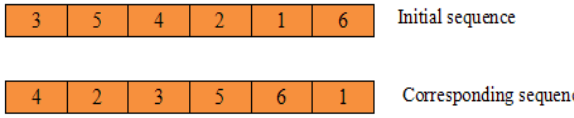
Figure 2. Corresponding sequence generation method.